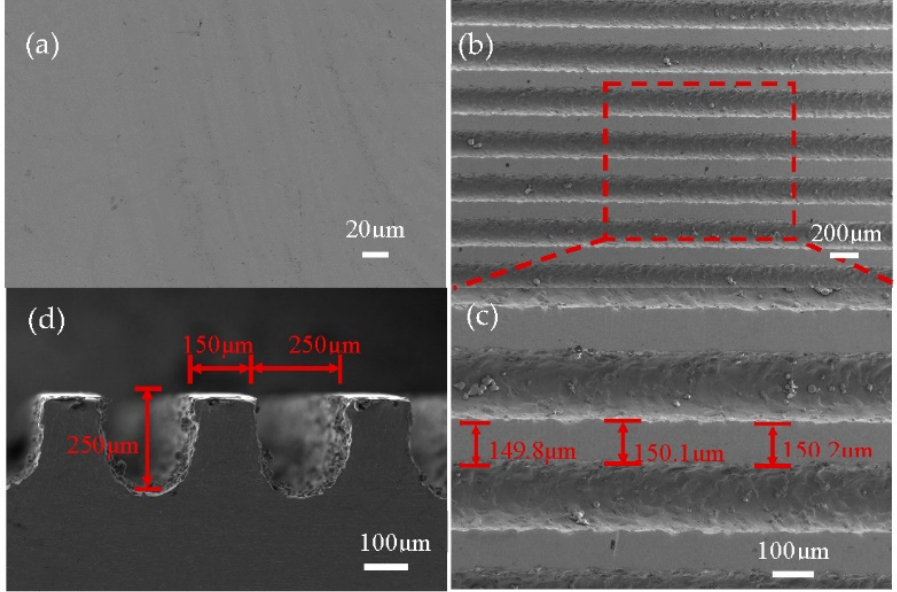
Figure 3. SEM image of groove morphology. ( a ) SEM image of titanium alloy plate. ( b ) Low magnification of the groove. ( c ) High magnification of the groove. ( d ) SEM image of the groove side view.